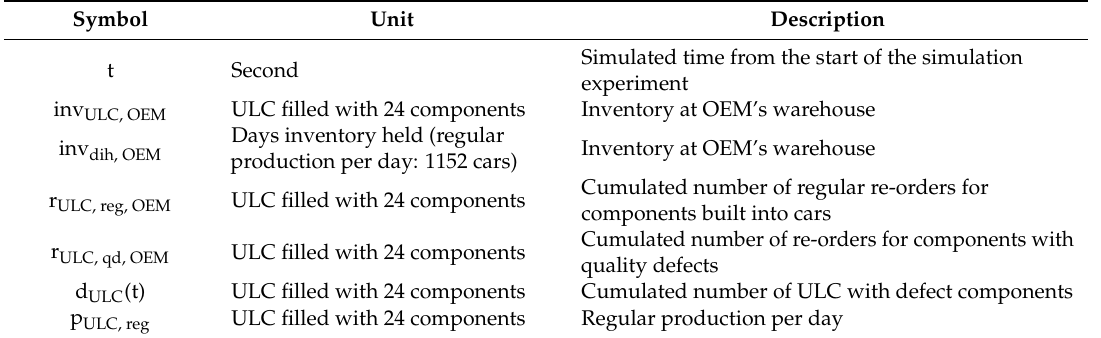
Table 7. Formula symbols and units.